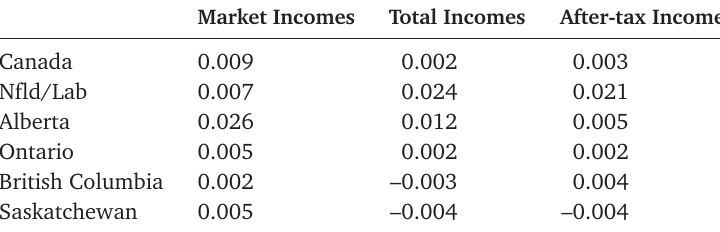
Table 4. Regional Impacts of Commodity Price Crash on Inequality Selected Provinces, Change in Gini Coefficient, 2014–15 Market